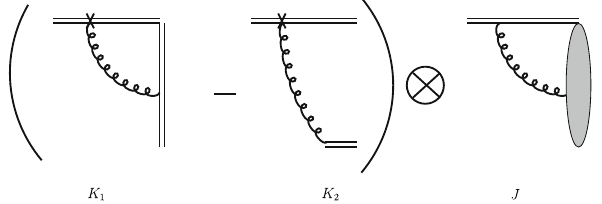
Fig. 2 Convolution of the O (α s ) soft function K with the jet function J , where the symbol × represents the special